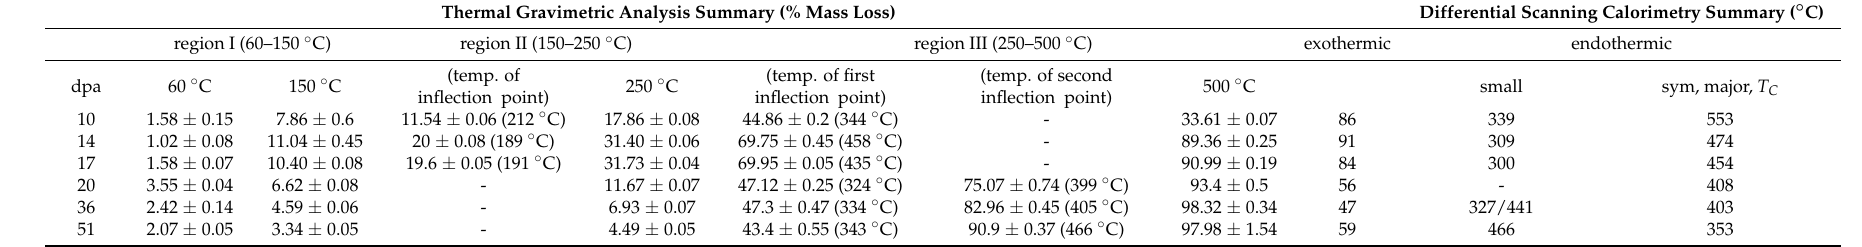
Table 1. Summary of the thermal behavior of Gossypium hirsutum fibers harvested at different stages of development (10, 14, 17, 20, 36 and 51 dpa). Thermal Gravimetric Analysis Summary (% Mass